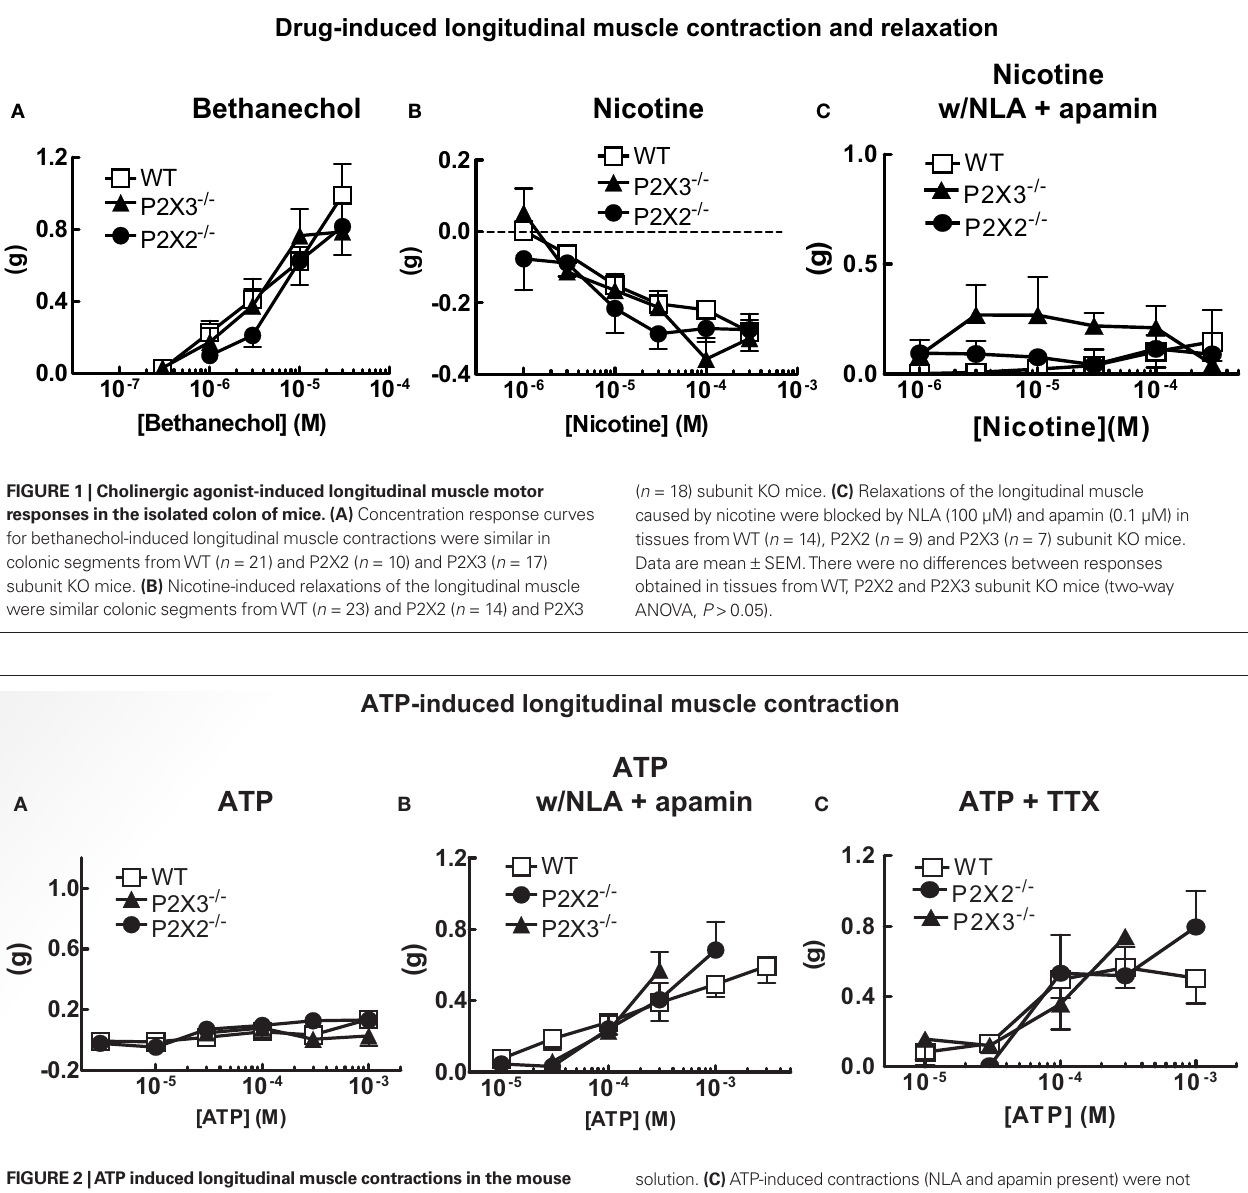
solution. (C) ATP-induced contractions (NLA and apamin present) were not blocked by TTX (0.3 μM) in colonic segments of WT ( n = 9) and P2X2 ( n = 6) and P2X3 ( n = 3) subunit KO mice. Data are mean ± SEM. In all of these studies there were no differences between responses obtained in tissues from WT, P2X2 and P2X3 subunit KO mice (two-way ANOVA, P >